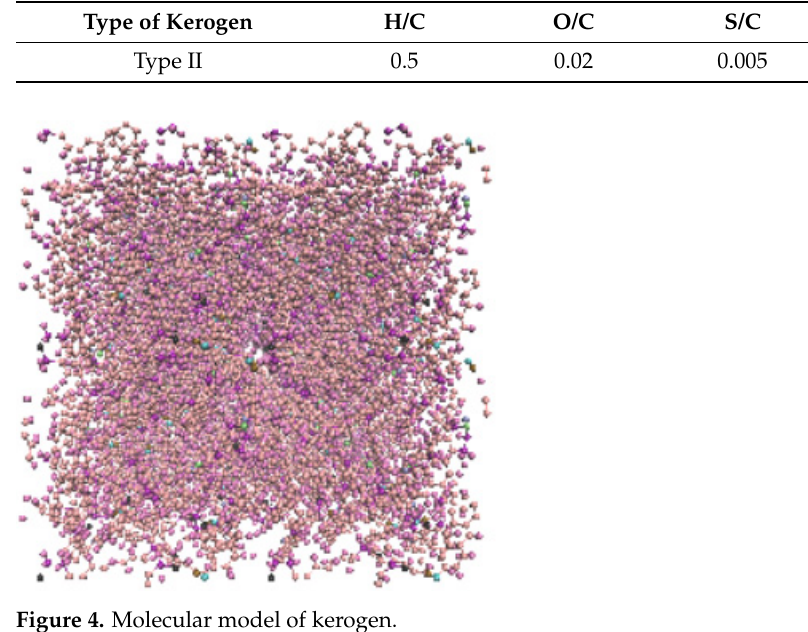
5 of 14 Figure 3. Schematic diagram of α -quartz structure. Red particles are oxygen atoms; yellow particles are silicon atoms. 2.4. Kerogen